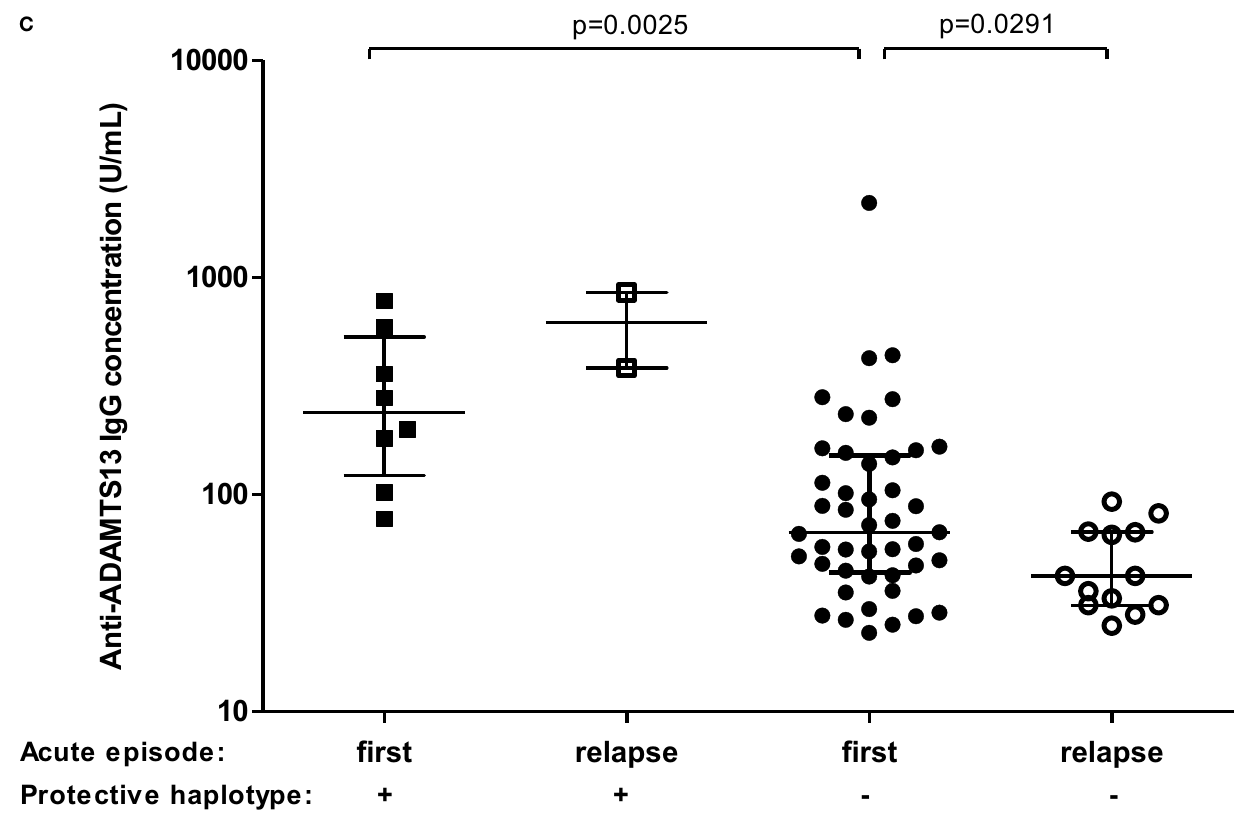
FigUre 7 | Anti-ADAMTS13 IgG levels in patients carrying or not carrying protective (DR7-DQ2 or DR13-DQ6) or risk (DR11-DQ3 or DR15-DQ6) HLA-DR-DQ haplotypes. Medians and interquartile ranges are shown. (a,B) Anti-ADAMTS13 IgG levels in the first available acute sample (either from the first acute episode or from relapse) of each patient with available HLA-DR-DQ data. The numbers below panel (B) show the number of risk or protective haplotypes carried by the patient. (c) Samples from the first acute episode and from relapse. + : protective haplotype carrier, − : not carrying protective